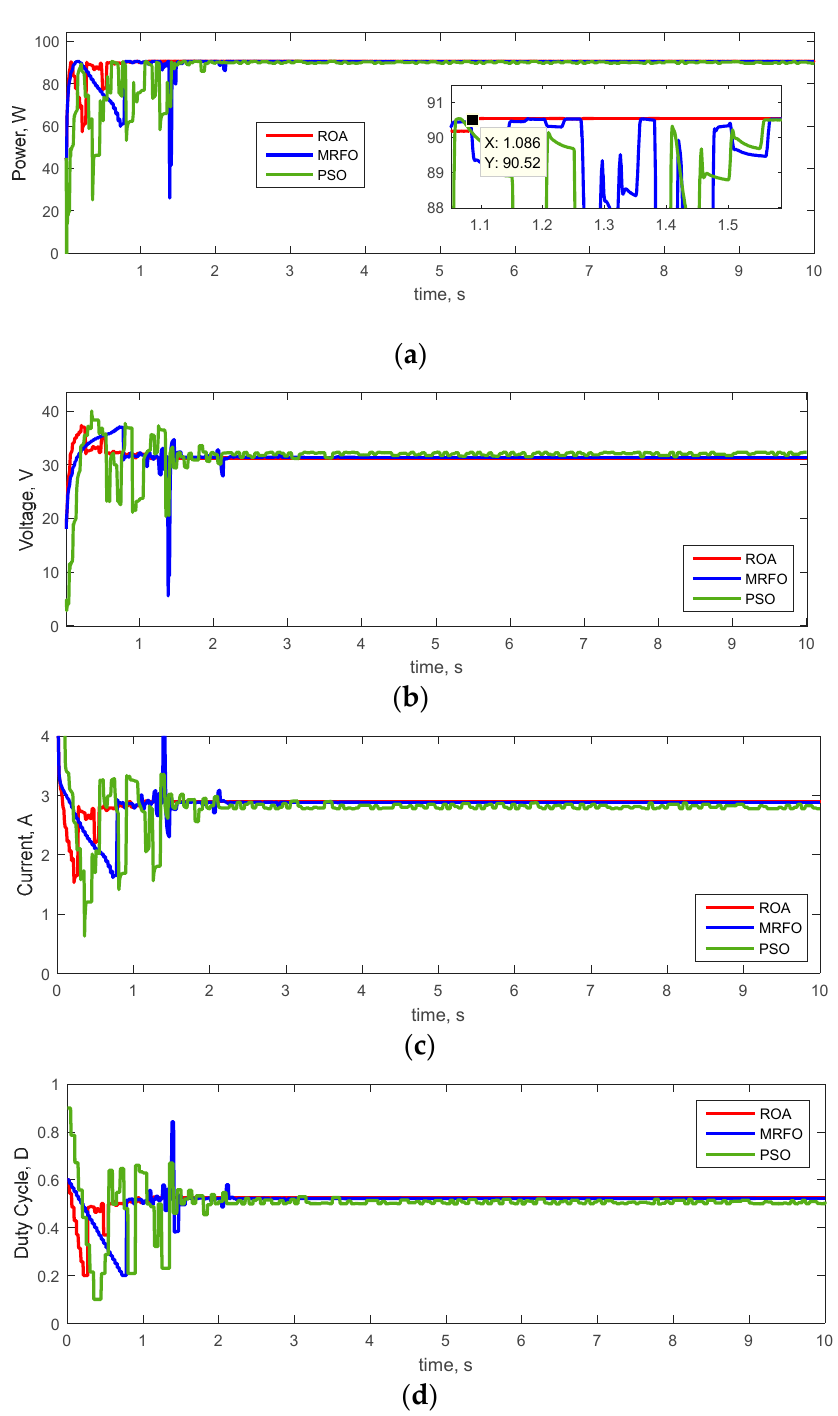
Figure 10. ( a ) PV power, ( b ) PV voltage, ( c ) PV current, ( d ) Duty cycle in pattern 2 using different methods.